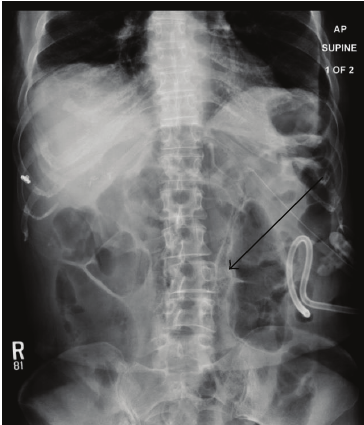
Figure 1: Abdominal radiograph demonstrates gastrostomy tube and jejunostomy tube in the left upper quadrant of the abdomen. Multiple small round lucencies are seen in the wall of loops of small bowel in the midabdomen (arrows).